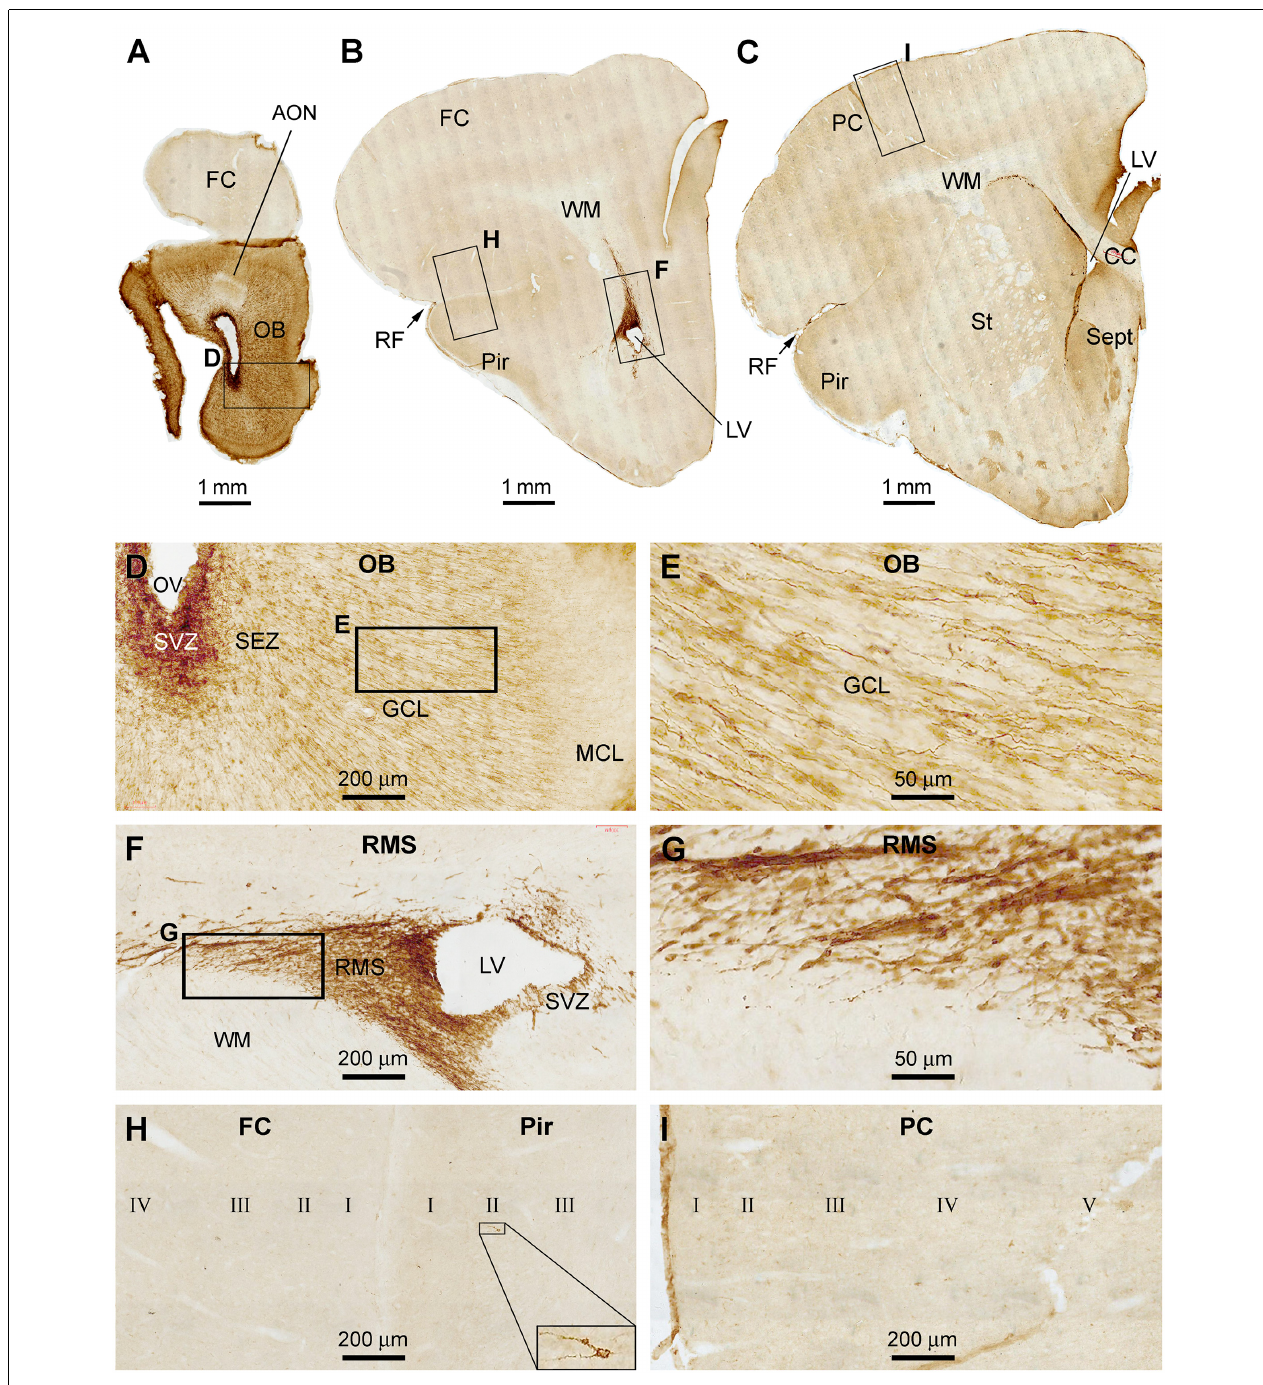
FIGURE 1 | Doublecortin immunoreactive (DCX+) profiles in the rostral part of the forebrain in a 2 months-old Chinese tree shrew. Panels (A–C) are low magnification images showing the labeling in the olfactory bulb (OB) at the levels of the anterior olfactory nucleus (AON) (A) , the beginning of piriform cortex (Pir) (B) , and septum (Sept) (C) , respectively. Framed areas are enlarged and illustrated as (D–I) . In the OB, DCX+ cells are densely packed at the subventricular zone (SVZ) surrounding the olfactory ventricle (OV). Moderately stained cells are present over the subependymal zone (SEZ) and granule cell layer (GCL) (D) . DCX+ granule cells are mostly bipolar or fusiform with their somata and processes oriented centroperipherally (E) . Panels (F,G) are higher magnification images illustrating DCX+ cellular chains forming the rostral migratory stream (RMS) from the SVZ in the frontal lobe. Panel (H) shows part of the frontal cortex (FC) and Pir surrounding rhinal fissure (RF), with no labeled cells in the former, whereas a few labeled cells in the latter (insert). Panel (I) shows the lack of DCX+ cells in the parental neocortex (PC). Additional abbreviations: CC, corpus collosum; St, striatum; WM, white matter; MCL, mitral cell layer; I, II ... VI: cortical layers. Scale bars are as indicated in individual image